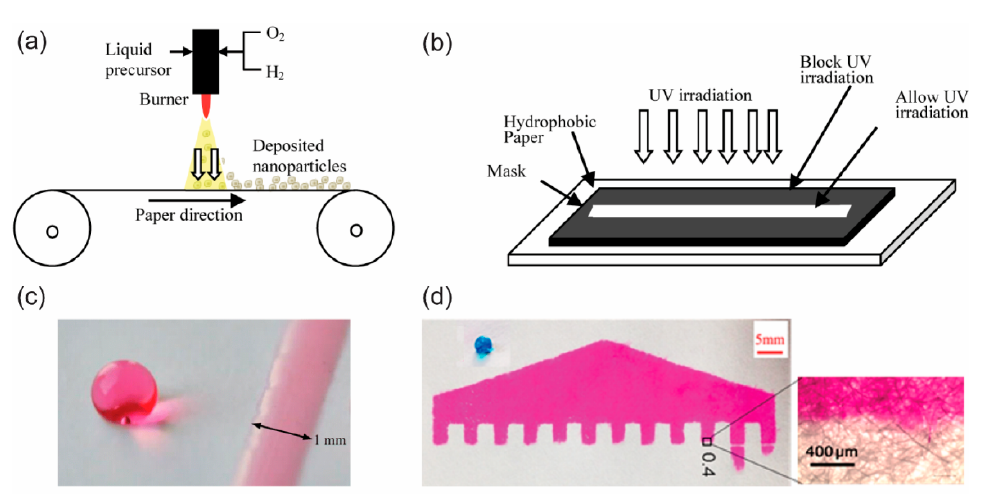
Figure 6. ( a , b ) Schematic showing the use of a laser to irradiate a hydrophobic surface to fabricate a p-CMF device. ( c ) Water droplet on a hydrophobic surface and the spreading of water on a hydrophilic surface that had been subjected to UV irradiation. Reprinted with permission from the authors of [58]. Copyright 2014 American Chemical Society. ( d ) A typical design of a fabricated p-CMF device, and a high magnification image of the boundary between the hydrophobic and the hydrophilic surfaces. Reprinted with permission from the authors of [62]. Copyright 2018 American Chemical Society. Table 1. Summary of published fabrication methods, materials, advantages, and disadvantages of for p-CMF devices.